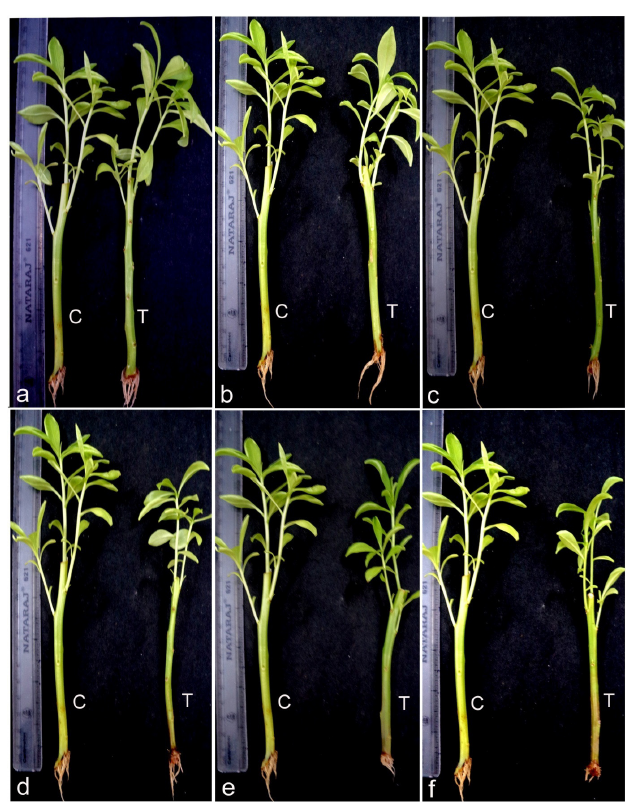
Fig. 2. Morphological aspects of Talinum portulacifolium exposed to 5 ppm (a), 15 ppm (b), 30 ppm (c), 40 ppm (d), 45 ppm (e) and 50 ppm (f) of Zinc. C, Control and T,